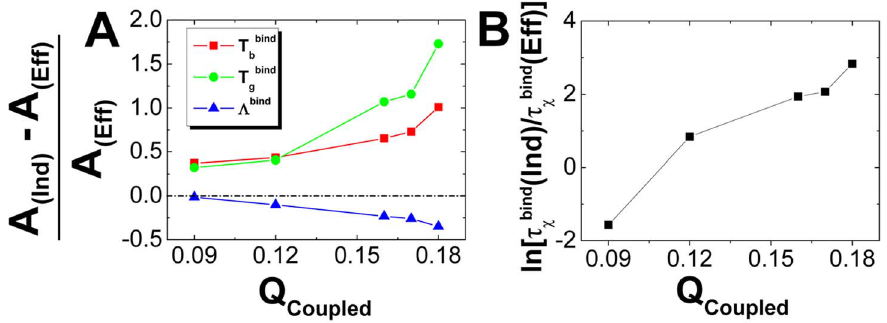
Figure 5. The differences between rigid and flexible binding energy landscapes changes with interfacial flexibility. (A) The differences A ( Ind ) { A ( Eff ) between rigid and flexible binding energy landscapes are described by the , where A ( Ind ) and A ( Eff ) are the quantities of the rigid and A ( Eff ) , T bind and L bind , corresponding to the binding transition temperature, glassy trapping temperature and flexible binding. The quantities A are T bind g b binding energy landscape topography measure, respectively. (B) The differences of kinetics, represented by the ratio of association time between rigid and flexible binding, are plotted as a function of Q Coupled . Q Coupled describes the degree of interfacial flexibility.